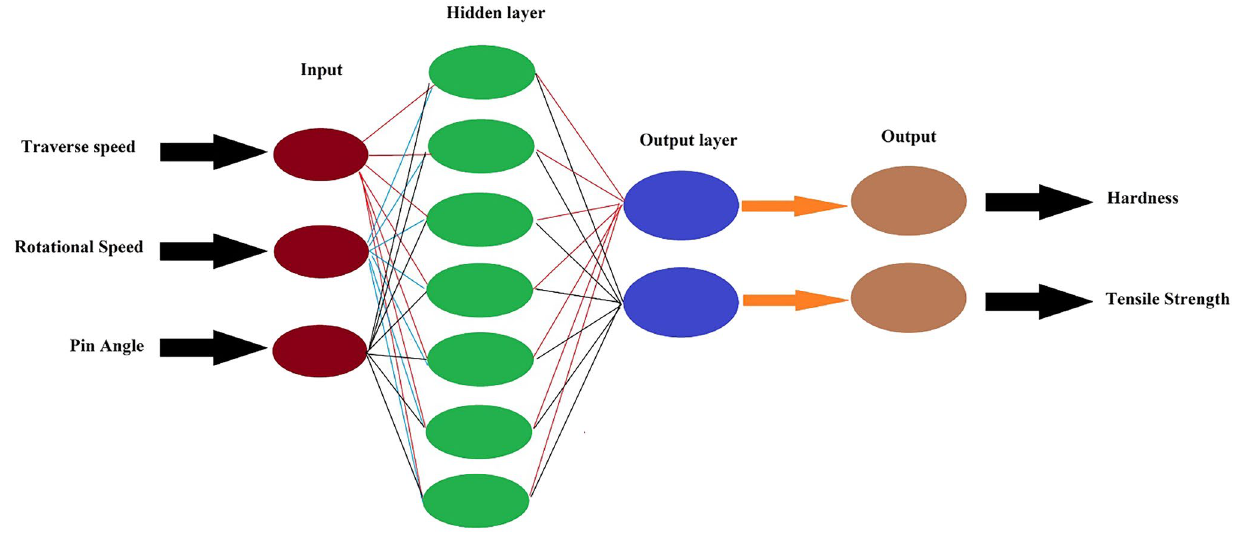
Fig. 3 Structure of neural